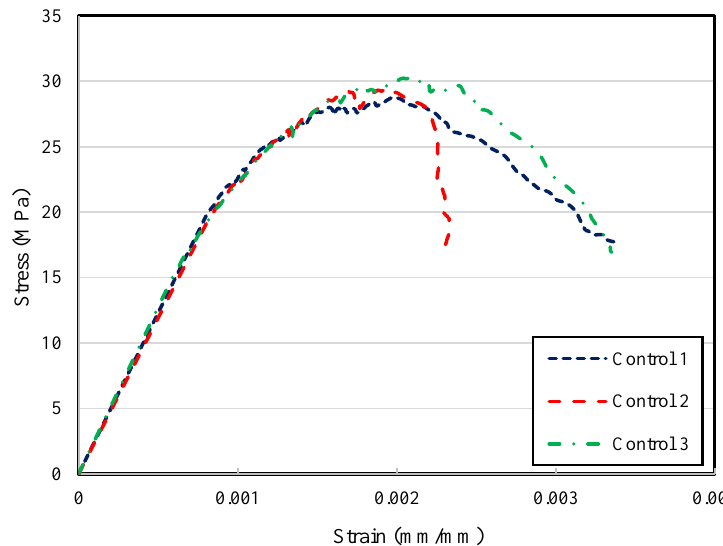
Figure 14. Stress-strain relationship of control specimens.